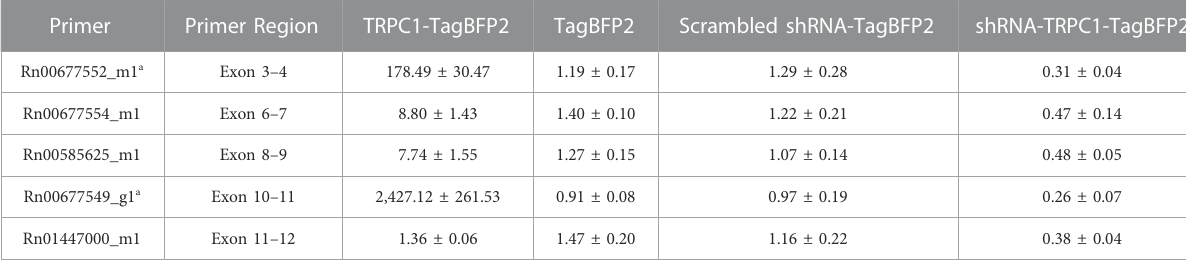
TABLE 1 Mean fold change of TRPC1 mRNA from WT NRVMs of all RT-qPCR primers.